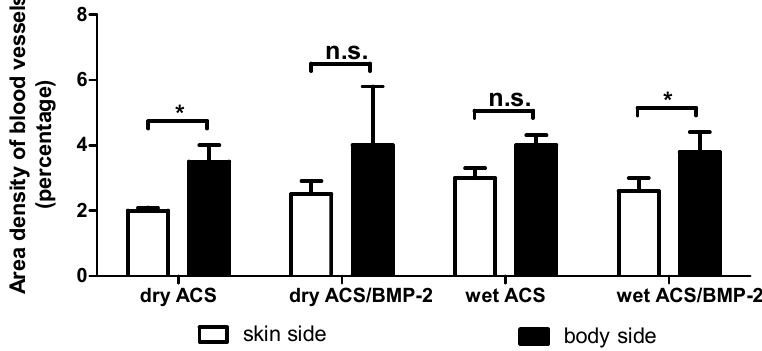
Figure 5. Area density of blood vessels in the dry and wet ACS implant groups, comparing the skin side blood vessel density with the lumbar body side blood vessel density. The data reveal that the density is significantly different physiologically. *: p < 0.05, n.s.: no significant difference.